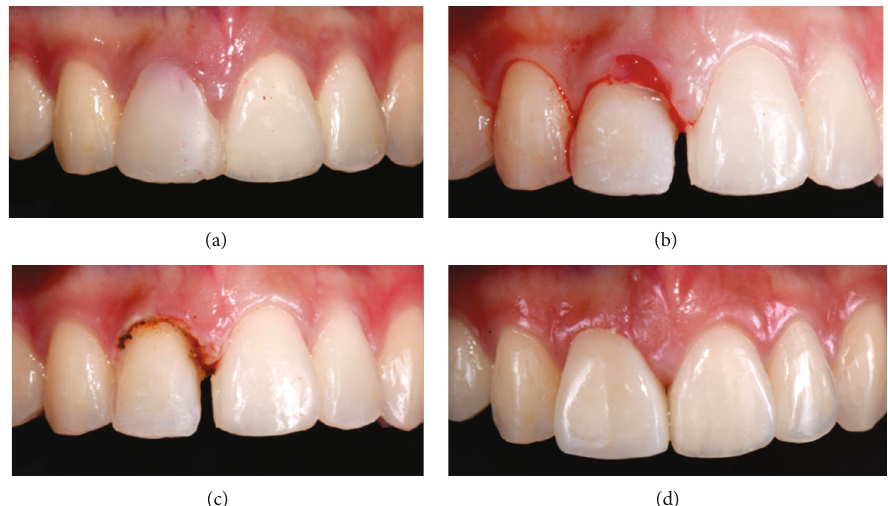
Figure 1: (a) Right lateral incisor in the position of the central incisor and built up with composite resin. (b) Gingival in fl ammation underneath the overhanging composite restoration. (c) Gingivoplasty with a diode laser. (d) Cemented veneer with excellent postoperative gingival healing.